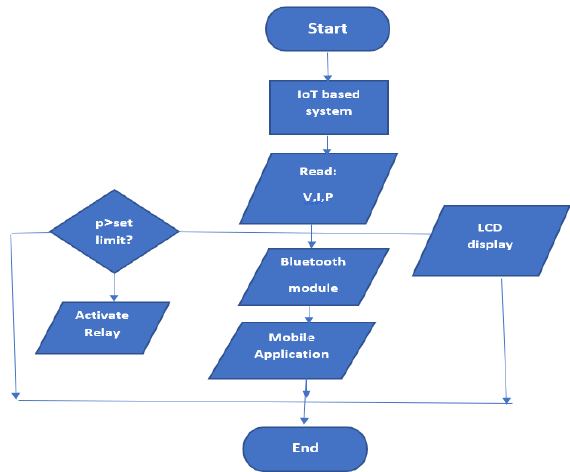
Figure 4. Flowchart of the distribution smart system.